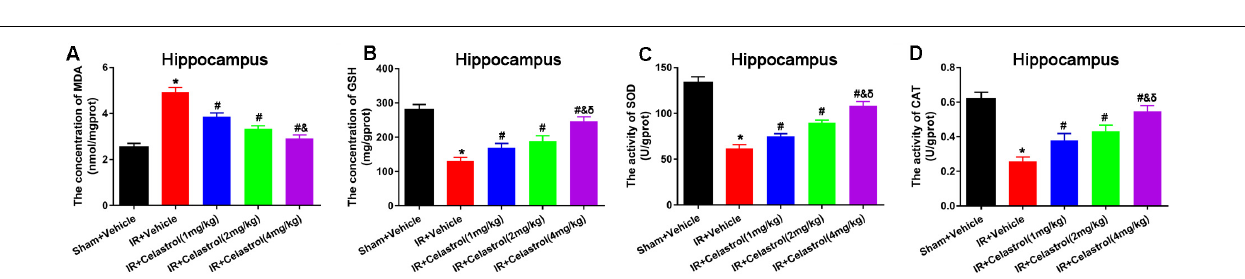
FIGURE 4 | Effects of celastrol on hippocampal and serum levels of TNF- α , IL-1 β ,.IL-6 and IL-10. (A) Hippocampal TNF- α level in vehicle or celastrol treated sham or tGCIR rats. (B) Hippocampal IL-1 β level in vehicle or celastrol treated sham or tGCIR rats. (C) Hippocampal IL-6 level in vehicle or celastrol treated sham or tGCIR rats. (D) Hippocampal IL-10 level in vehicle or celastrol treated sham or tGCIR rats. (E) Serum TNF- α level in vehicle or celastrol treated sham or tGCIR rats. (F) Serum IL-1 β level in vehicle or celastrol treated sham or tGCIR rats. (G) Serum IL-6 level in vehicle or celastrol treated sham or tGCIR rats. (H) Serum IL-10 level in vehicle or celastrol treated sham or tGCIR rats. The error bars represent mean ± SEM ( n = 4, * P < 0.05 vs. Sham + Vehicle group; # P < 0.05 vs. IR+ Vehicle group; & P < 0.05 vs. IR + Celastrol (1 mg/kg) group; δ P < 0.05 vs. IR + Celastrol (2 mg/kg) group).